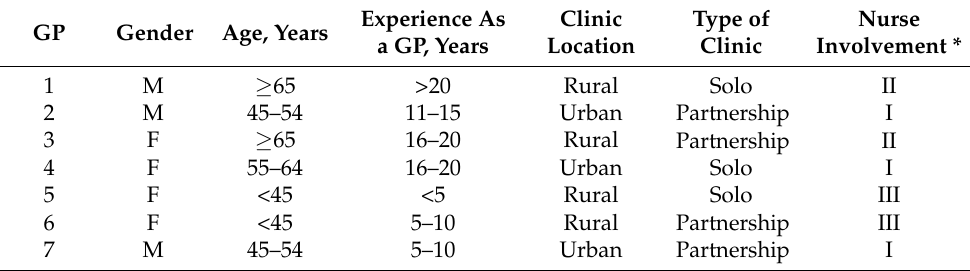
Table 1. Characteristics of